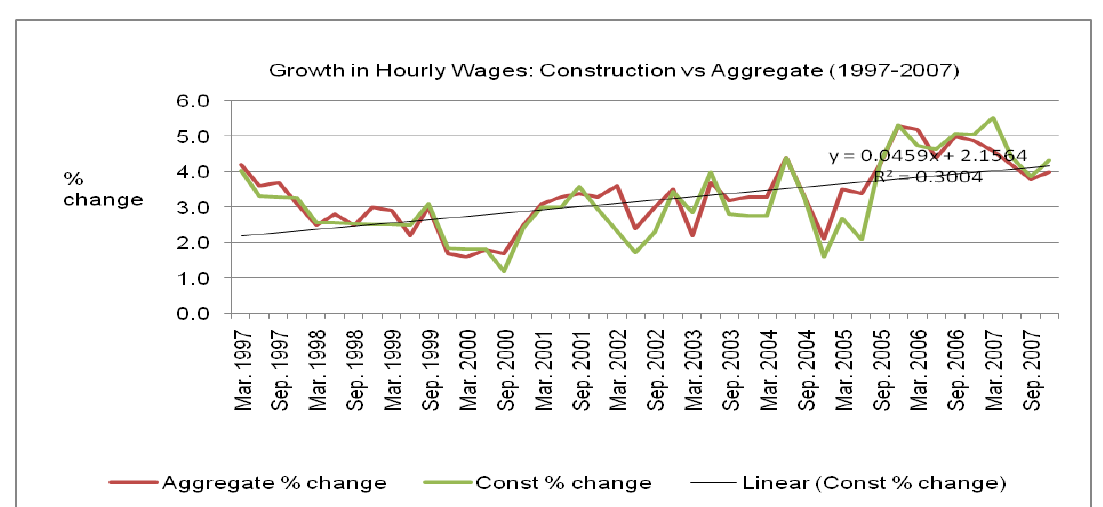
Figure 9 Growth in Hourly Wages: Construction v Aggregate